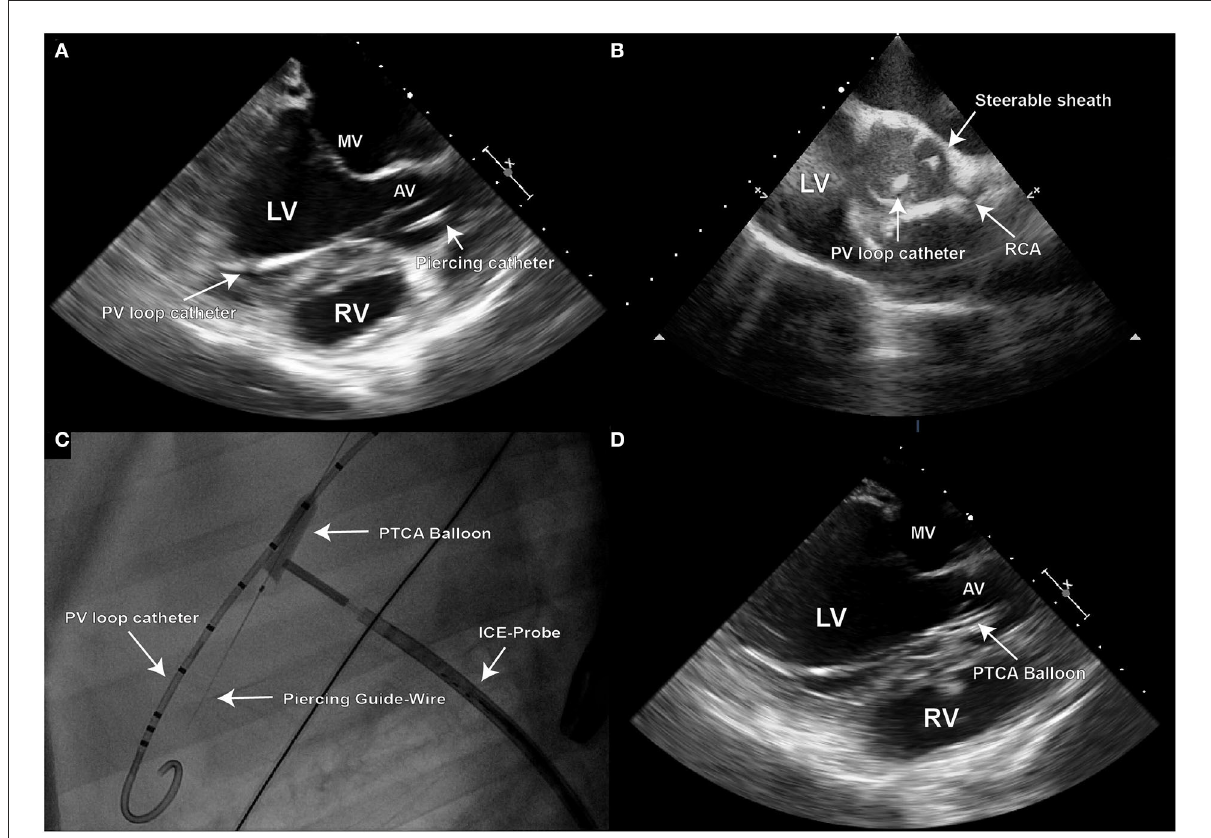
FIGURE2 Due to the 2D character of echocardiographic imaging, two distinct perpendicular projections (long and short axis) are necessary for precise procedural navigation; (A) Transesophageal (TEE) long axis echo image demonstrating the final position of the steerable sheath on target for creation of the defect at the leaflet hinge point in the right coronary cusp (RCC) of the aortic valve; (B) Once such position is reached, intra-cardiac echo should be used to confirm the position in the short axis image; (C) Fluoroscopy is used to visualize the piercing guide wire during its positioning, and for control of the PTCA balloon inflation; (D) Inflated PTCA balloon used for defect dilation can be also visualized in TEE long axis